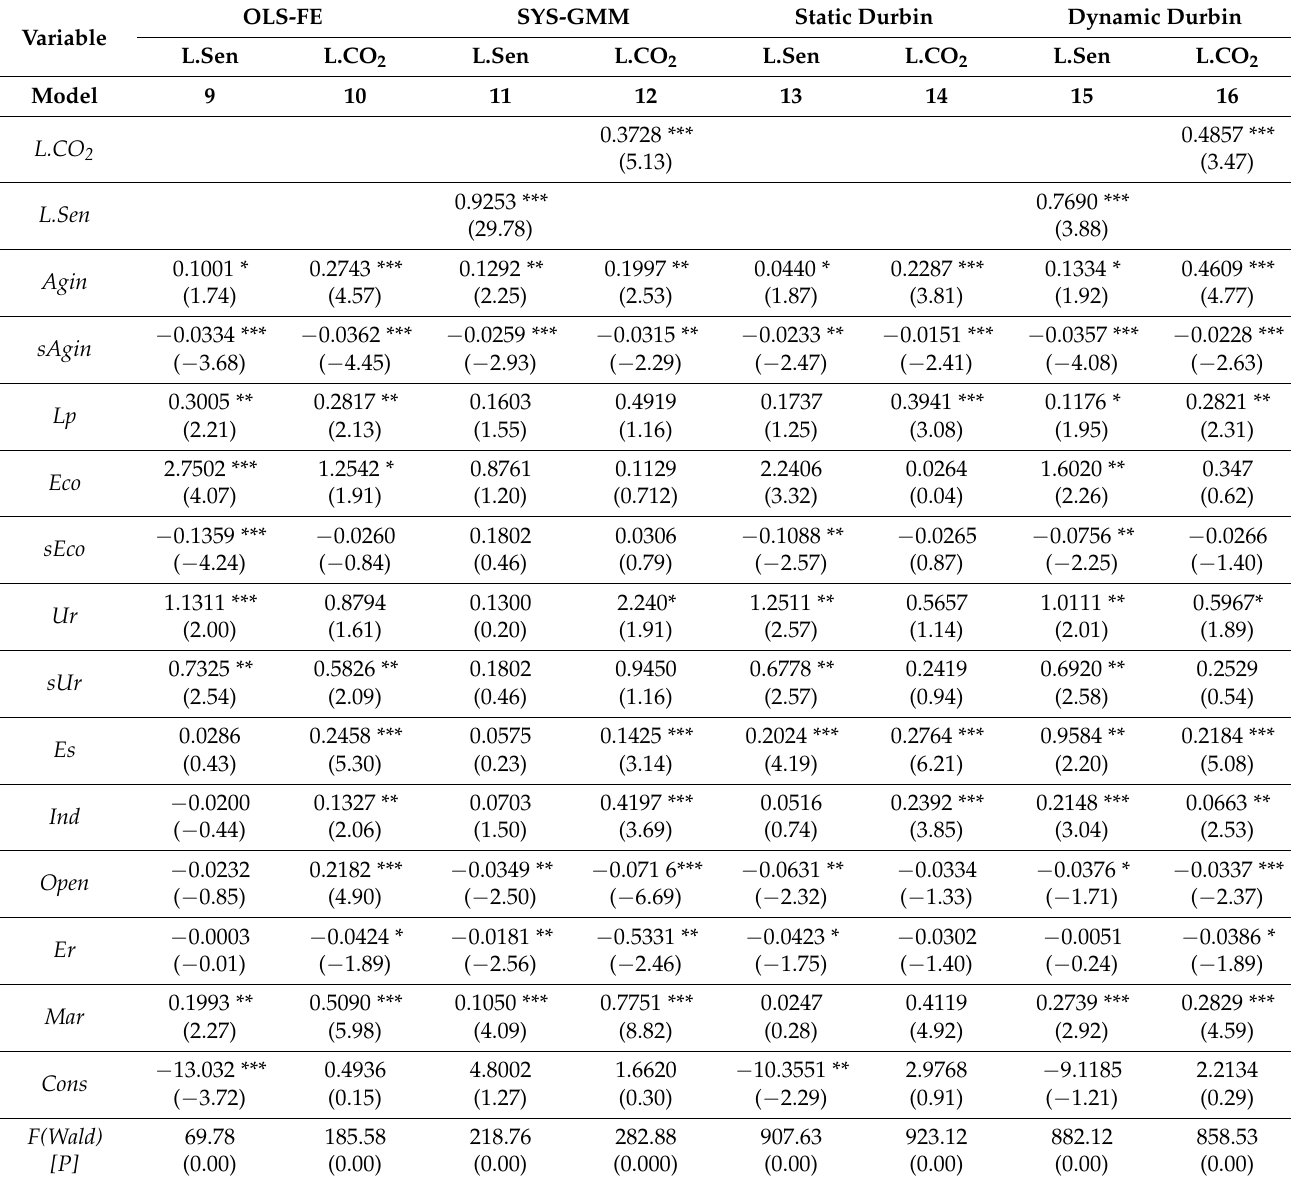
Table 6. Energy intermediation effect test based on carbon emission